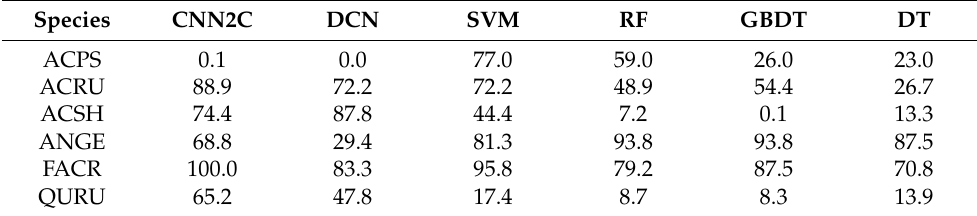
Table 6. Correct prediction ratio for comparison methods in application phase